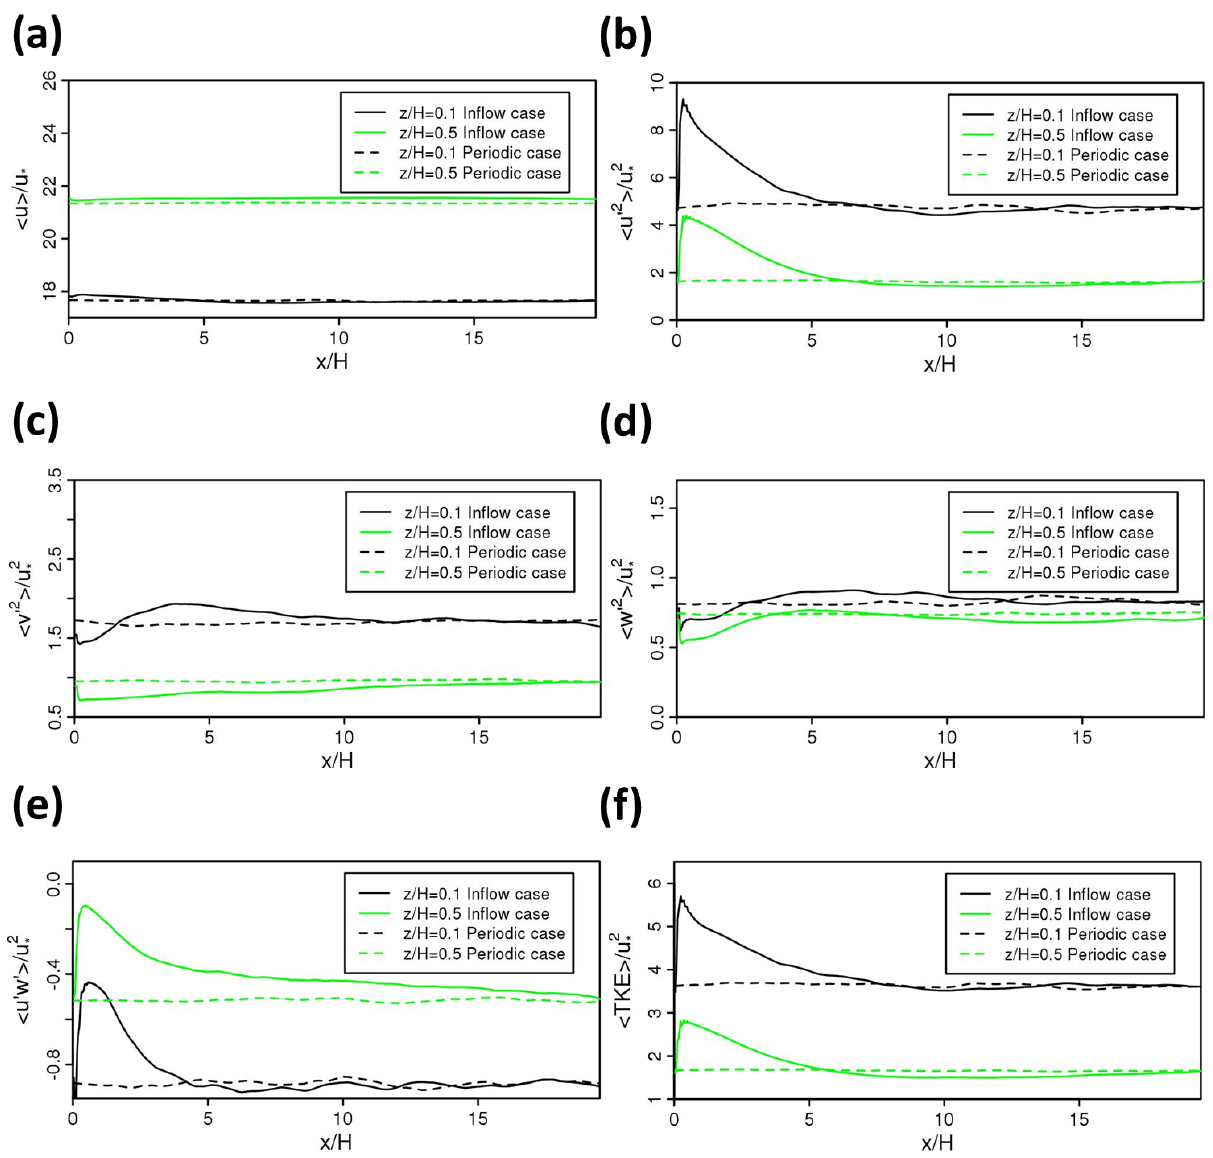
Figure 4. Horizontal profiles (spatially and temporally averaged) of (a) (cid:104) u (cid:105) /u ∗ , (b) (cid:104) u (cid:48) 2 (cid:105) /u 2 ∗ , (c) (cid:104) v (cid:48) 2 (cid:105) /u 2 ∗ , (d) (cid:104) w (cid:48) 2 (cid:105) /u 2 ∗ , (e) (cid:104) u (cid:48) w (cid:48) (cid:105) /u 2 ∗ , and (f) (cid:104) TKE (cid:105) /u 2 ∗ at z/H = 0 . 1 and z/H = 0 . 5 in the periodic case and the inflow case